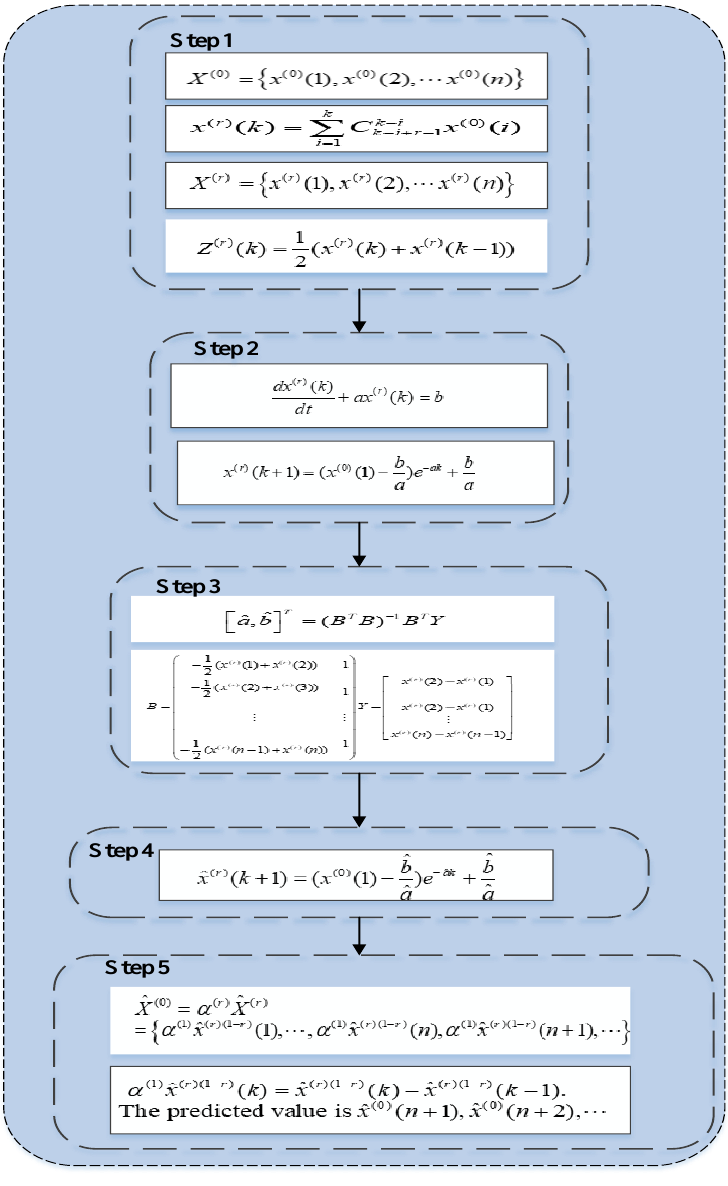
Figure 2. Framework diagram of FGM(1,1). View x ( 1 ) ( k ) and y ( 1 ) ( k ) as research variables in order to explore the long-term rela- tionship between X ( 0 ) and Y ( 0 ) . Actually, the data before x ( 0 ) ( k ) often exert an influence on x ( 0 ) ( k ) and y ( 0 ) ( k ) , that is to say the accumulation of x ( 0 ) ( k ) will exert an influence on x ( 0 ) ( k ) and y ( 0 ) ( k ) . According the grey modeling method, at time k , the grey derivative of the X ( 1 ) is, The mean generated sequence of consecutive of X ( 1 ) is Z the mean generated sequence of consecutive neighbors of Y ( 1 ) is Z where k = 1, 2, . . . , n − 1. The